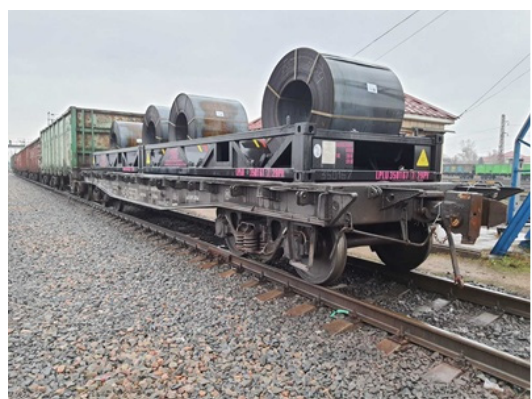
Figure 14. Flatcar coupled to the retaining wall.